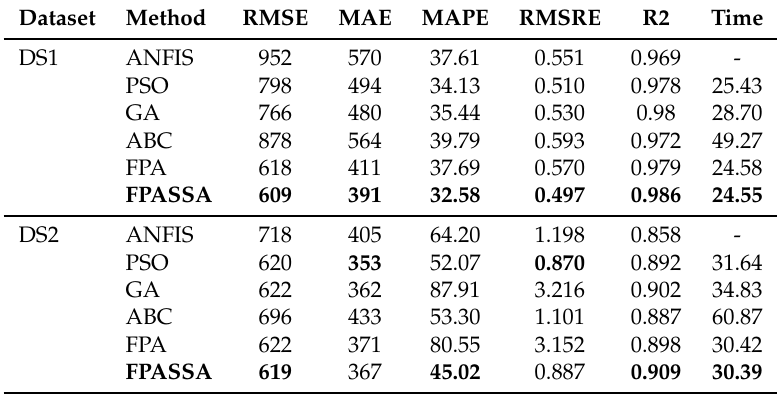
Table 3. Computational results for datasets of confirmed influenza